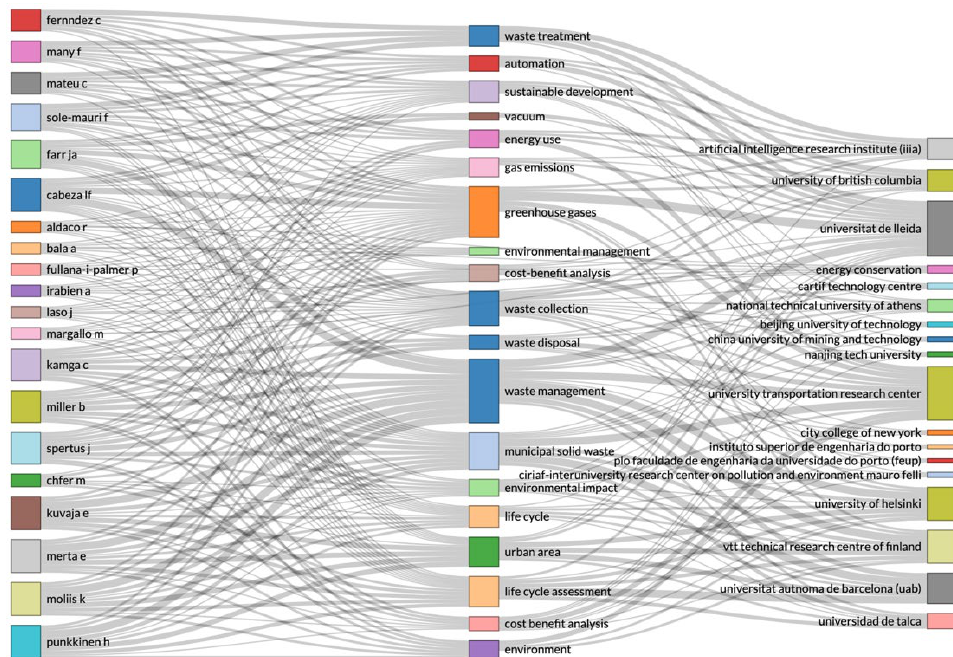
Figure 3. Three-field plot relating keywords, authors, and affiliations using R-studio software and bibliometrix library of the automated waste collection system (AWCS) scientific literature found in Scopus.